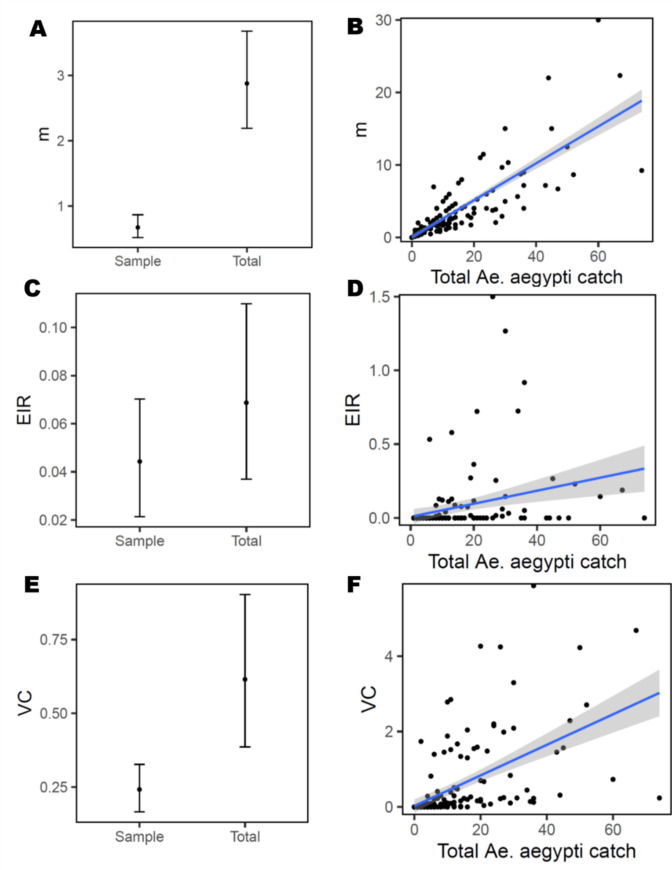
Household-level estimates of ABV transmission potential.The proportion of vectors per host (m), entomologic inoculation rate (EIR) and vectorial capacity (VC) were calculated per house and used to compare estimated between the first 10-min collection (sample) and the Ae. aegypti total catch (Total)(panels A, C, E). Panels B, D and F show the association between total Ae. aegypti female abundance per house, and estimates of m, EIR and VC, respectively. Lines show the fit and confidence interval of a generalized-linear mixed model fitted to the data (S3 Table).